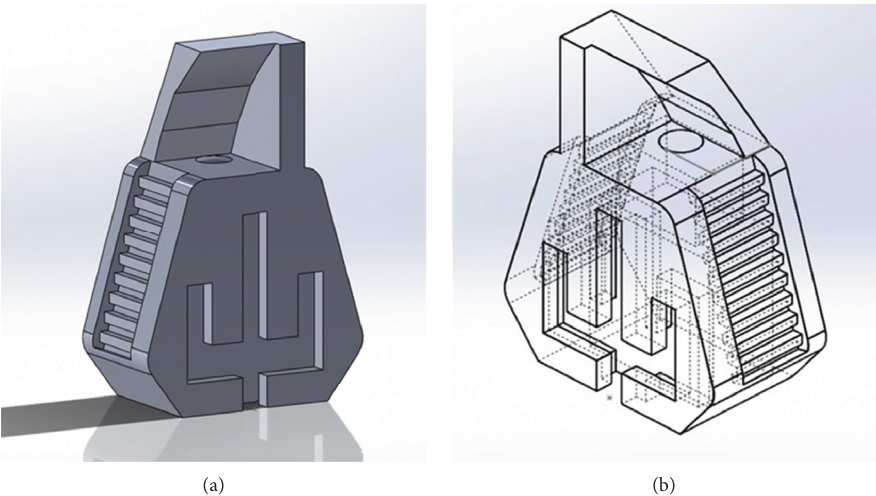
Figure 6: Schematic diagram of oral lighting structure.